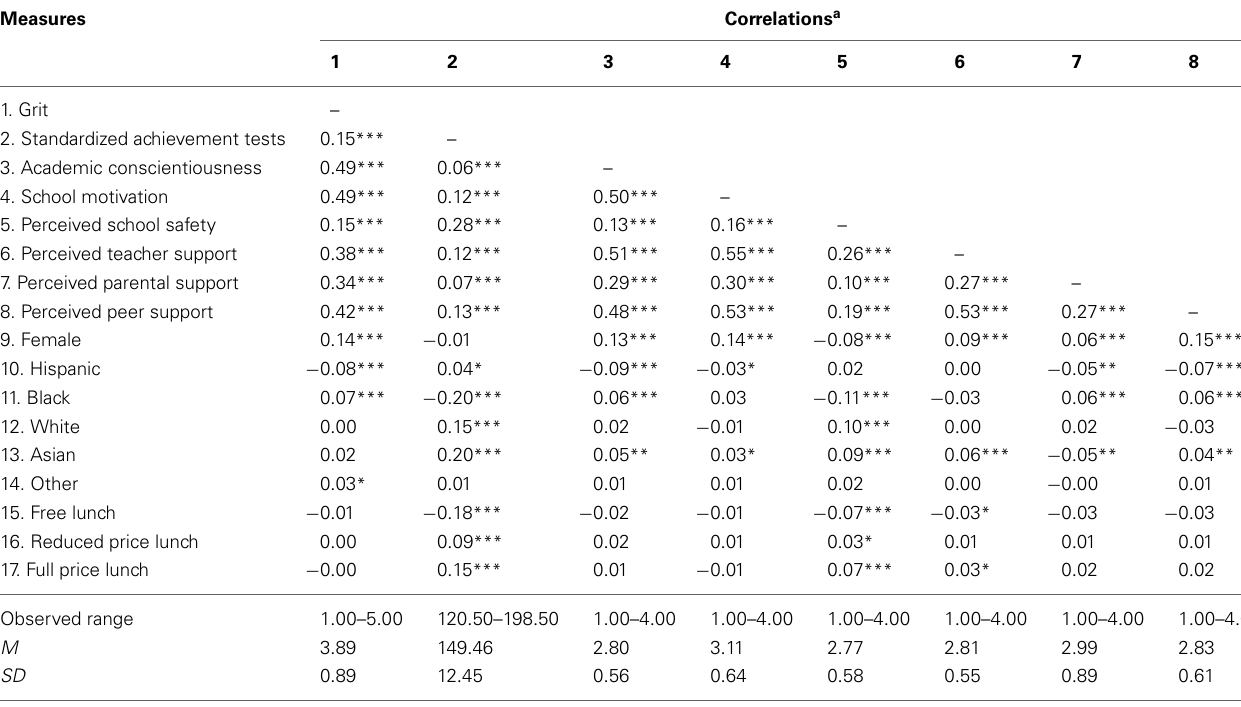
Table 3A | Summary statistics and intercorrelations for Chicago public school students (Study 3).